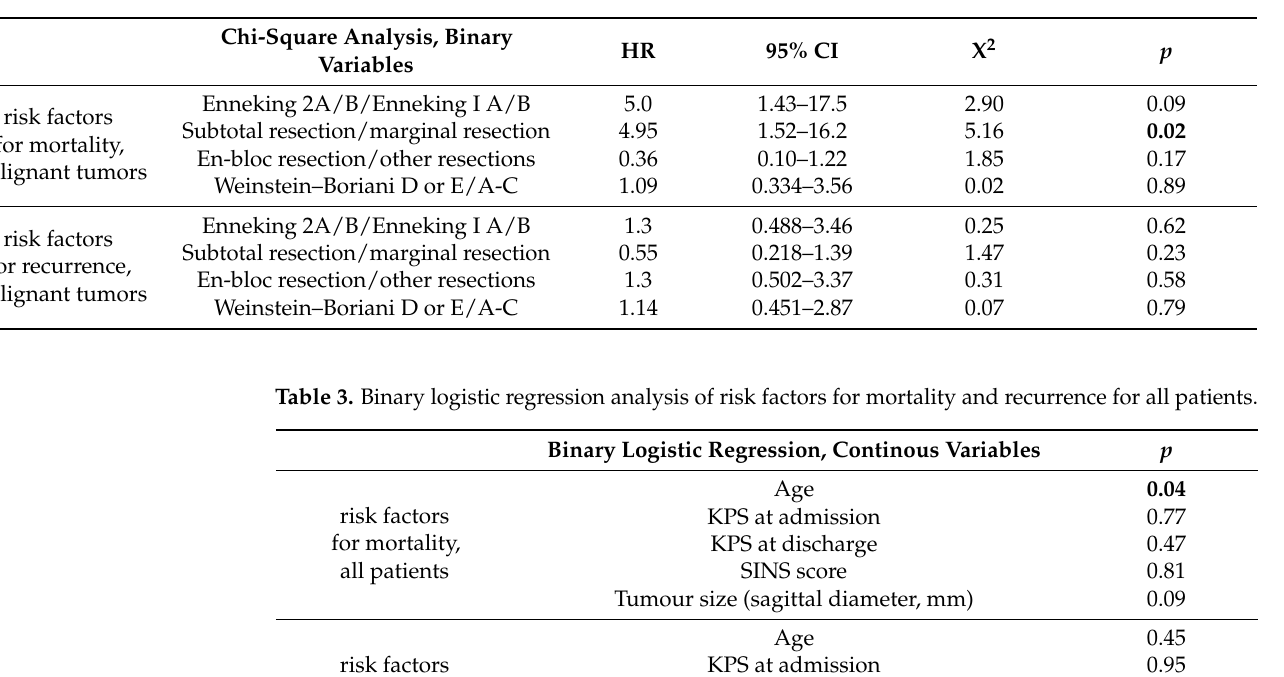
Table 2. Chi-square analysis of binary variables analyzing risk factors for mortality and recurrence for patients with malignant tumors.